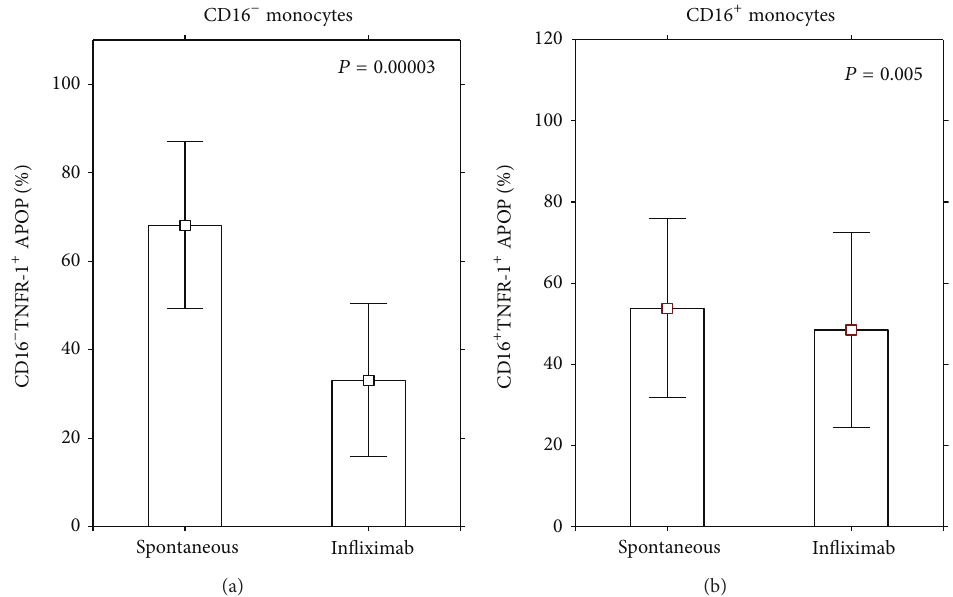
Figure 5: Effect of infliximab on apoptotic CD16 − and CD16 + TNFR1 + monocytes in diabetes mellitus type 1 patients. Peripheral blood mononuclear cells from 60 DM1 patients were incubated for 24 hours in a culture medium and then stained for visualization of the CD14, CD16, and TNF-R1 molecules. Next cellular pellet was incubated for further 15 minutes with fluorochrome-conjugated Annexin V to calculate the number of Annexin V-positive cells. The percentage of CD16 − and CD16 + TNF-R1 + apoptotic cells was summarized and presented as an arithmetic mean ± S.D. Statistical significance was calculated by means of the Kruskal-Wallis Anova test.